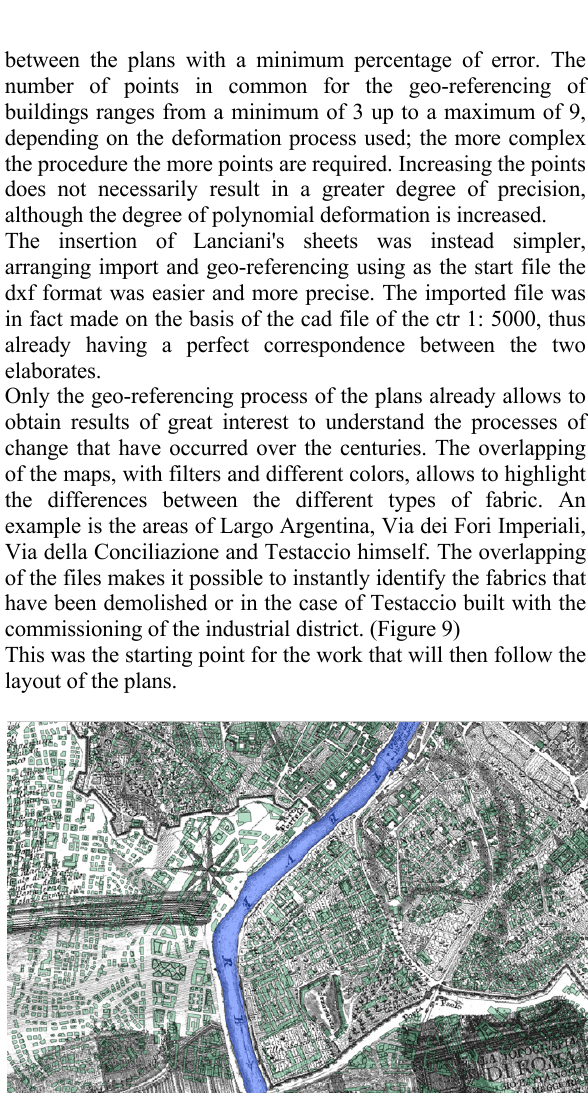
Figure 10. QGIS elaboration of the representation of the route of the Aurelian Walls and of the related entrance gates to the city. The ancient course of the Tiber river is also in evidence. In transparency the georeferenced Nolli plant and the fabric implemented extrapolated from the CTR 1: